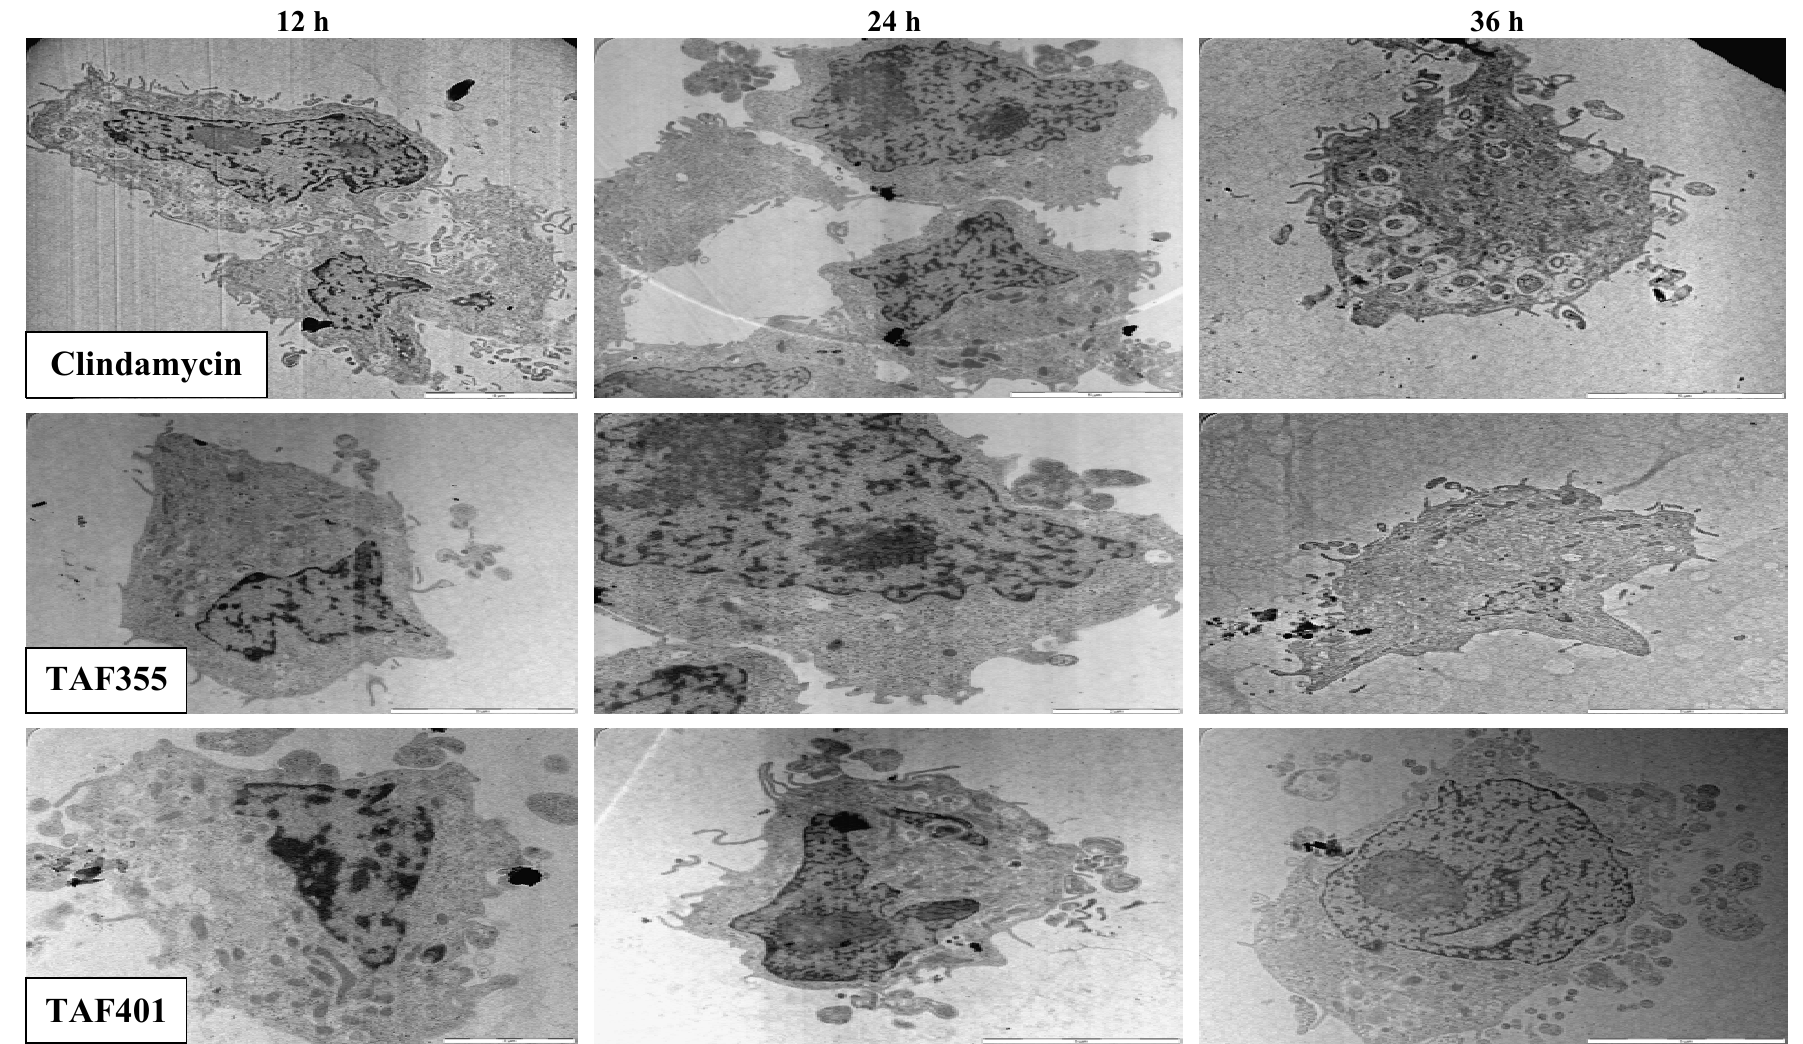
Figure 5. TEM micrographs of the treated treated cells of T. gondii for different time